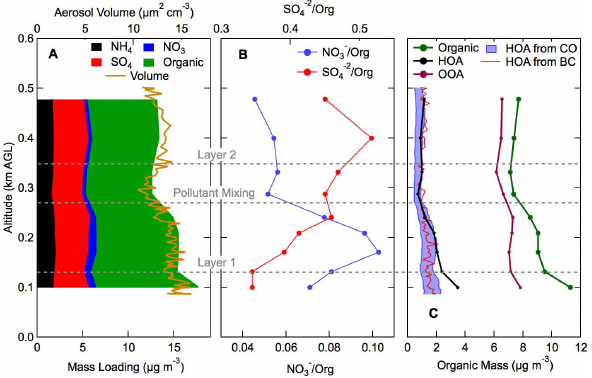
Fig. 4. Vertical profile of (A) Aerosol ammonium, sulfate, nitrate and organic, stacked together as a sum (bottom axis) and aerosol volume (top axis); (B) ratio of aerosol nitrate to organic (bottom axis) and sulfate to organic (top axis); and (C) organic aerosol mass compared to AMS estimates for OOA (secondary aerosol) and HOA (primary aerosol), and primary aerosol mass loadings estimated from carbon monoxide (CO) and black carbon (BC) (see text for description). Data are for descent to Hooks on 8 October, 09:33 lo- cal time. Grey dashed lines indicate the same layer structure shown in Fig.